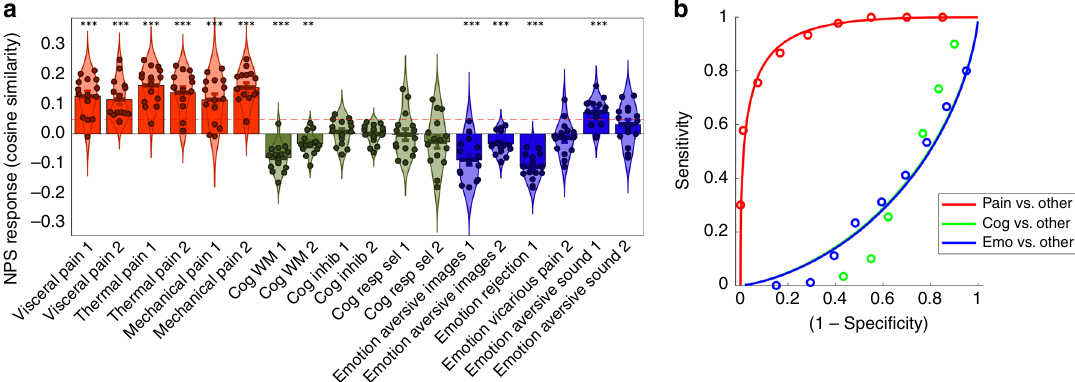
Fig. 3 Neurologic pain signature (NPS) expression discriminates brain responses to painful and nonpainful experimental manipulations. a Bar plots (mean ± standard error) and violin plots of NPS expression for 18 studies ( N = 15 for each study), including experiments that evoked painful sensations (red) or manipulated cognitive control (green) or negative emotion (blue). Each circle indicates NPS expression (quanti fi ed using cosine similarity) for an individual subject. The dashed line indicates the cutoff that maximizes overall accuracy in pain/no-pain classi fi cation. * P < 0.05, ** P < 0.01, *** q FDR < 0.05 (two-tailed, one-sample t test). b Receiver-operator characteristic curves of NPS classi fi cation of pain (red), cognitive control (green), and negative emotion (blue). Circles indicate deciles of NPS response and solid lines show the Gaussian model fi ts. Source data are provided as a Source Data fi q < 0.05 false discovery rate (FDR)-corrected 32 ). For each of the visceral ( N = 89) and somatic subsets ( N = 76), we controlled for the effect of the study using covariates for differences across studies (four visceral studies and three somatic studies, total N = 165, see “ Methods ” for details).